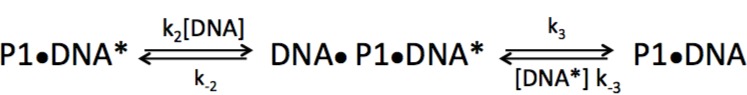
Kinetic model for the dissociation of PARP1 from labeled DNA that depends on formation of a ternary complex with the unlabeled DNA.